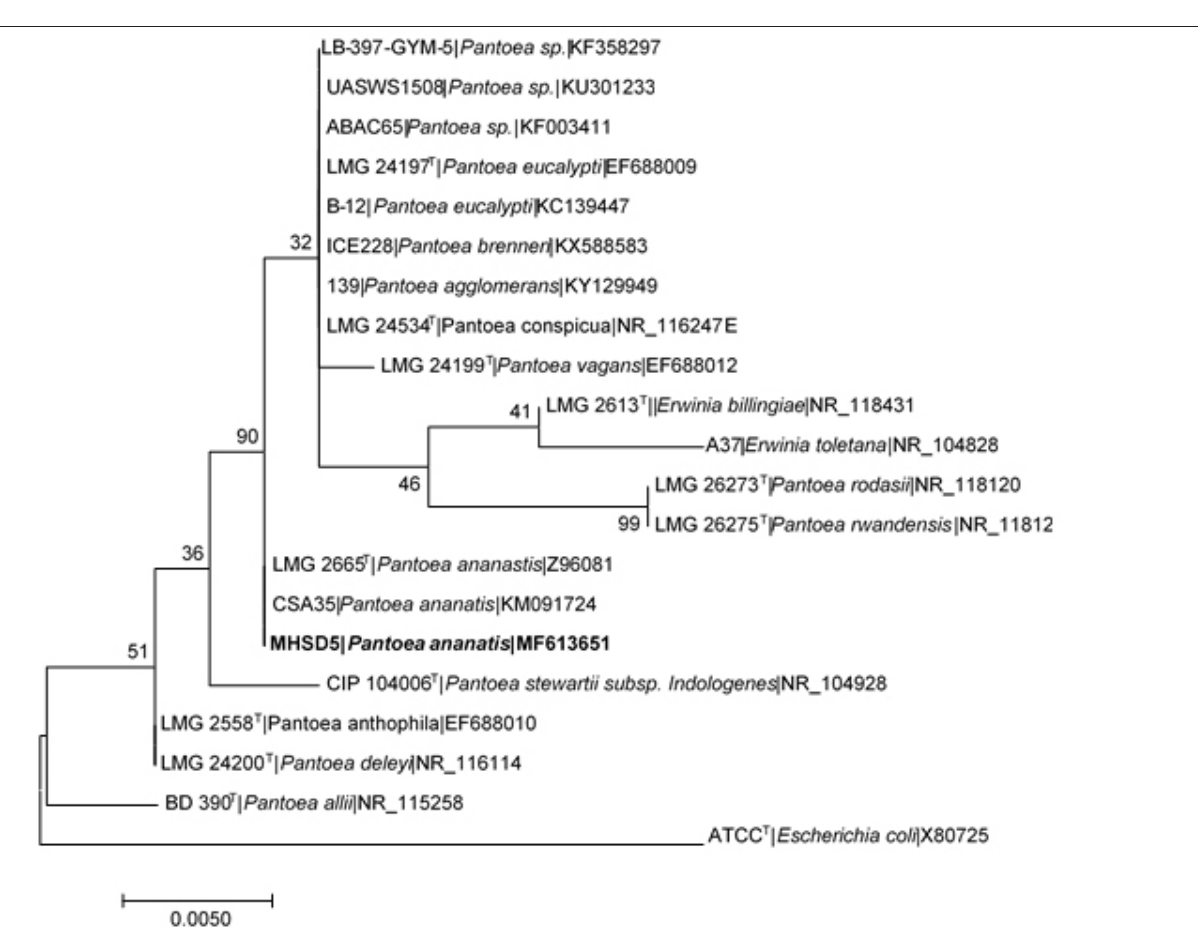
Figure 4: Maximum likelihood tree based on the 16S rRNA gene sequences of Pantoea sp. strain MHSD4 and its closest phylogenetic neighbours. The numbers on nodes indicate bootstrap values after 1000 replicates expressed in percentages. Escherichia coli strain ATCC X80725 was included as an outgroup. T indicates type strains.